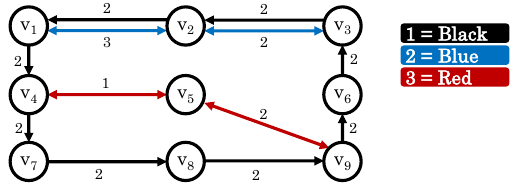
Figure 2. A small network comprising n = 9 vertices, m = 16 edges and k = 3 colours. As per Definition 1 we have, for example, E − ( v 1 ) = { ( v 2 , v 1 ,1 ) , ( v 2 , v 1 ,2 ) } , E + ( v 1 ) = { ( v 1 , v 2 ,2 ) , ( v 1 , v 4 ,1 ) } , C − ( v 1 ) = { 1,2 } and C + ( v 1 ) = { 1,2 }